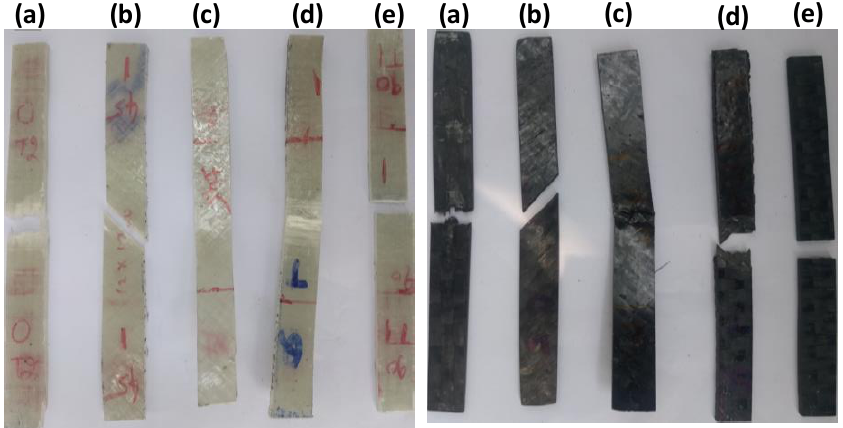
Figure 11. Fractured surfaces after flexural testing of glass/epoxy and carbon/epoxy composite specimens for different fiber orientations: ( a ) 0, ( b ) 45, ( c ) (45/−45/45)s, ( d ) (±45/0/90)s and ( e ) 90.